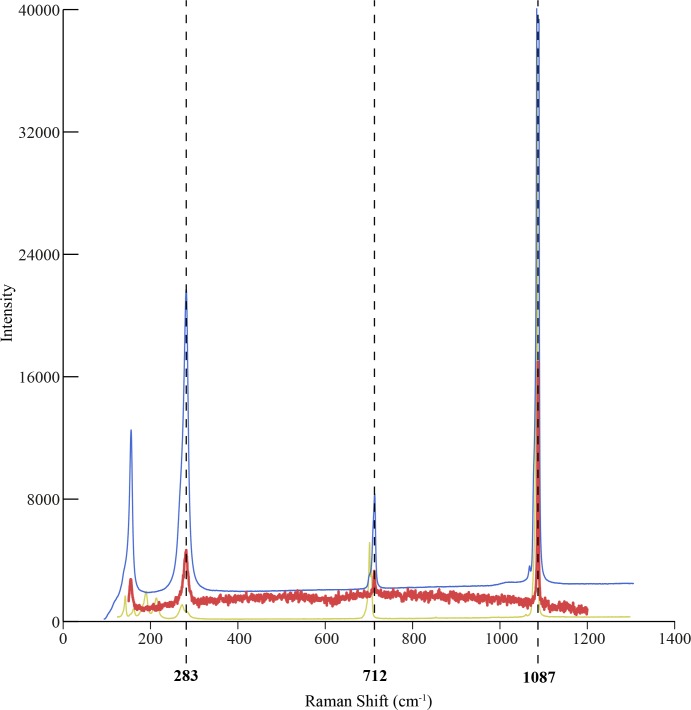
Raman spectrum of CH-7.Values measured are compared to Raman spectra of reference calcite and aragonite (RRUFF database; [68]. Comparison shows that CH-7 consists of calcite.